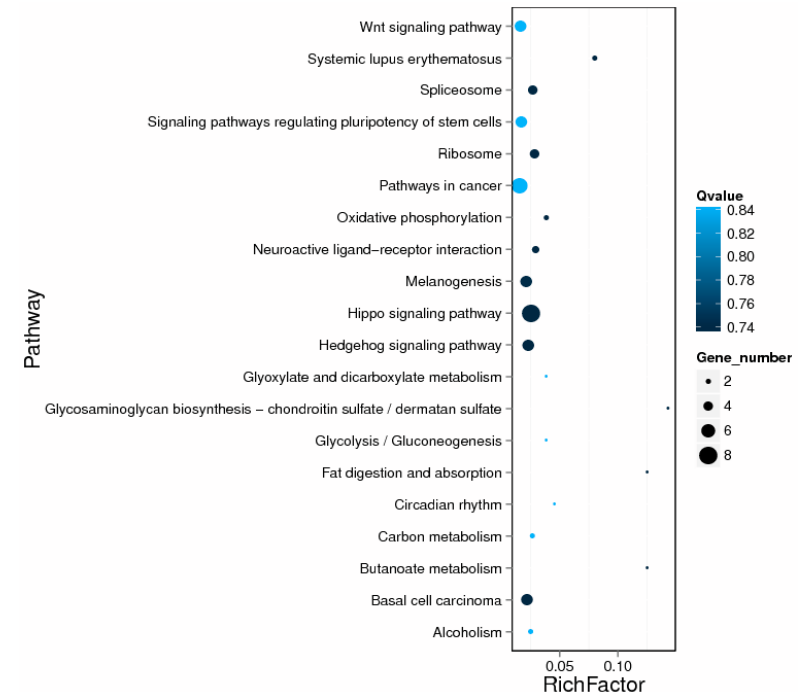
denominator represents the number of reference genes with GO annotation, and the numerator represents the number of reference genes annotated in the listed GO term. Corrected p -value: the p - value in the hypergeometric test after correction.